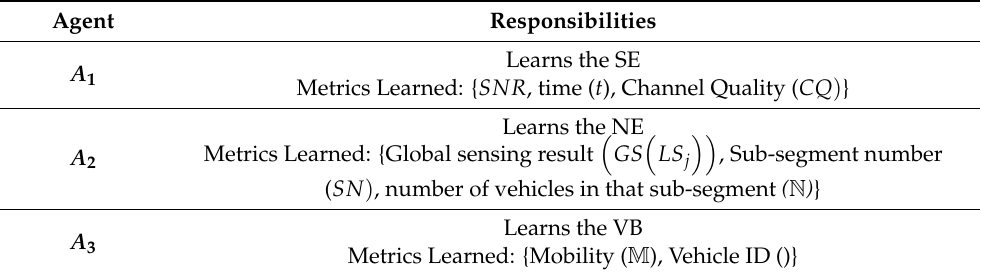
Table 1. Tri-agents and